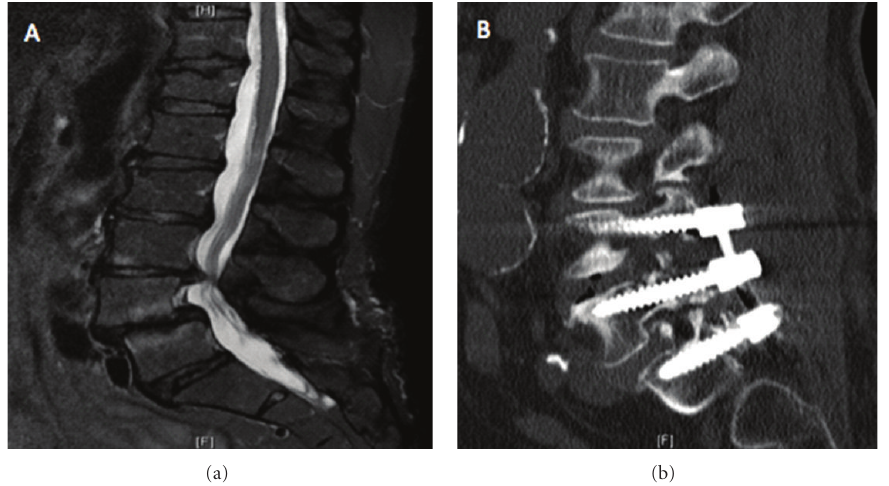
Figure 2: (a) Preoperative lateral MR image of a 66 y/o female with L4/L5 and L5/S1 spondylolisthesis and neuroforaminal stenosis; (b) Post-operative lateral MR image from a patient who underwent an MI-TLIF for spondylolisthesis at L4/L5,